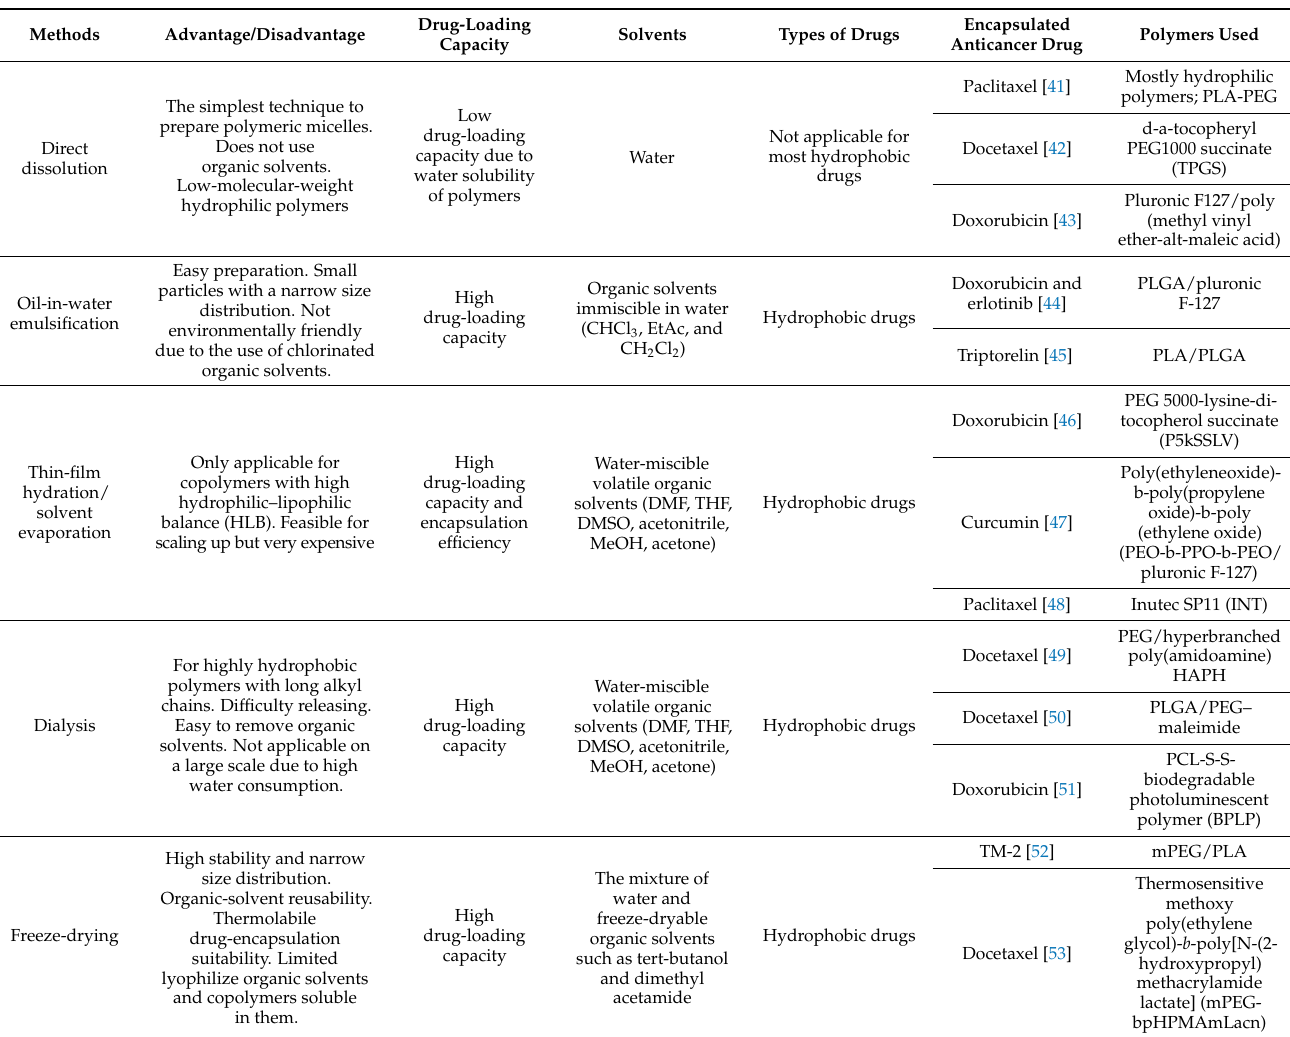
Table 1. Preparation methods of the polymeric micelles